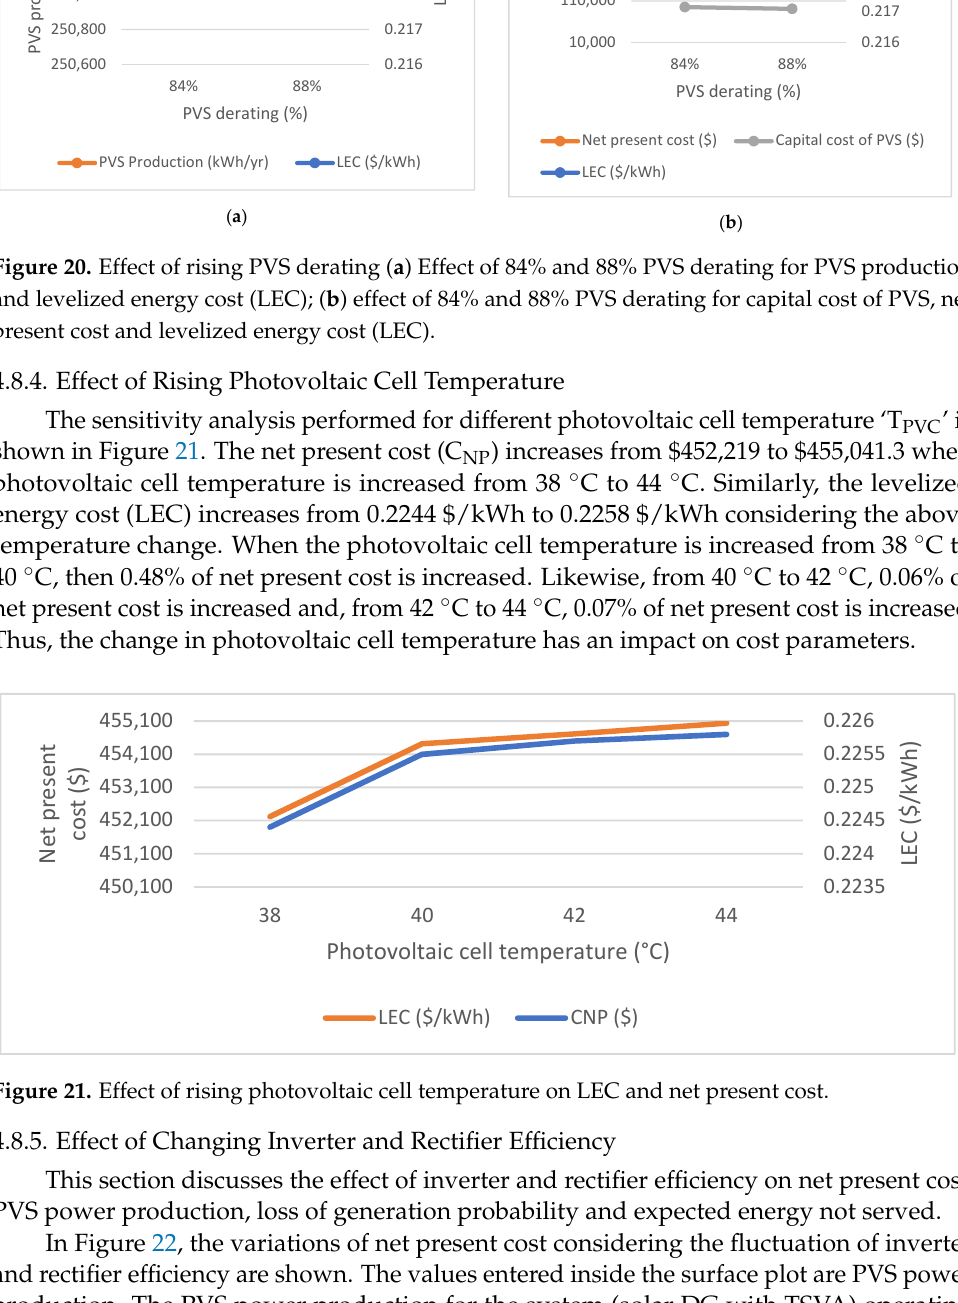
Figure 21. Effect of rising photovoltaic cell temperature on LEC and net present cost.